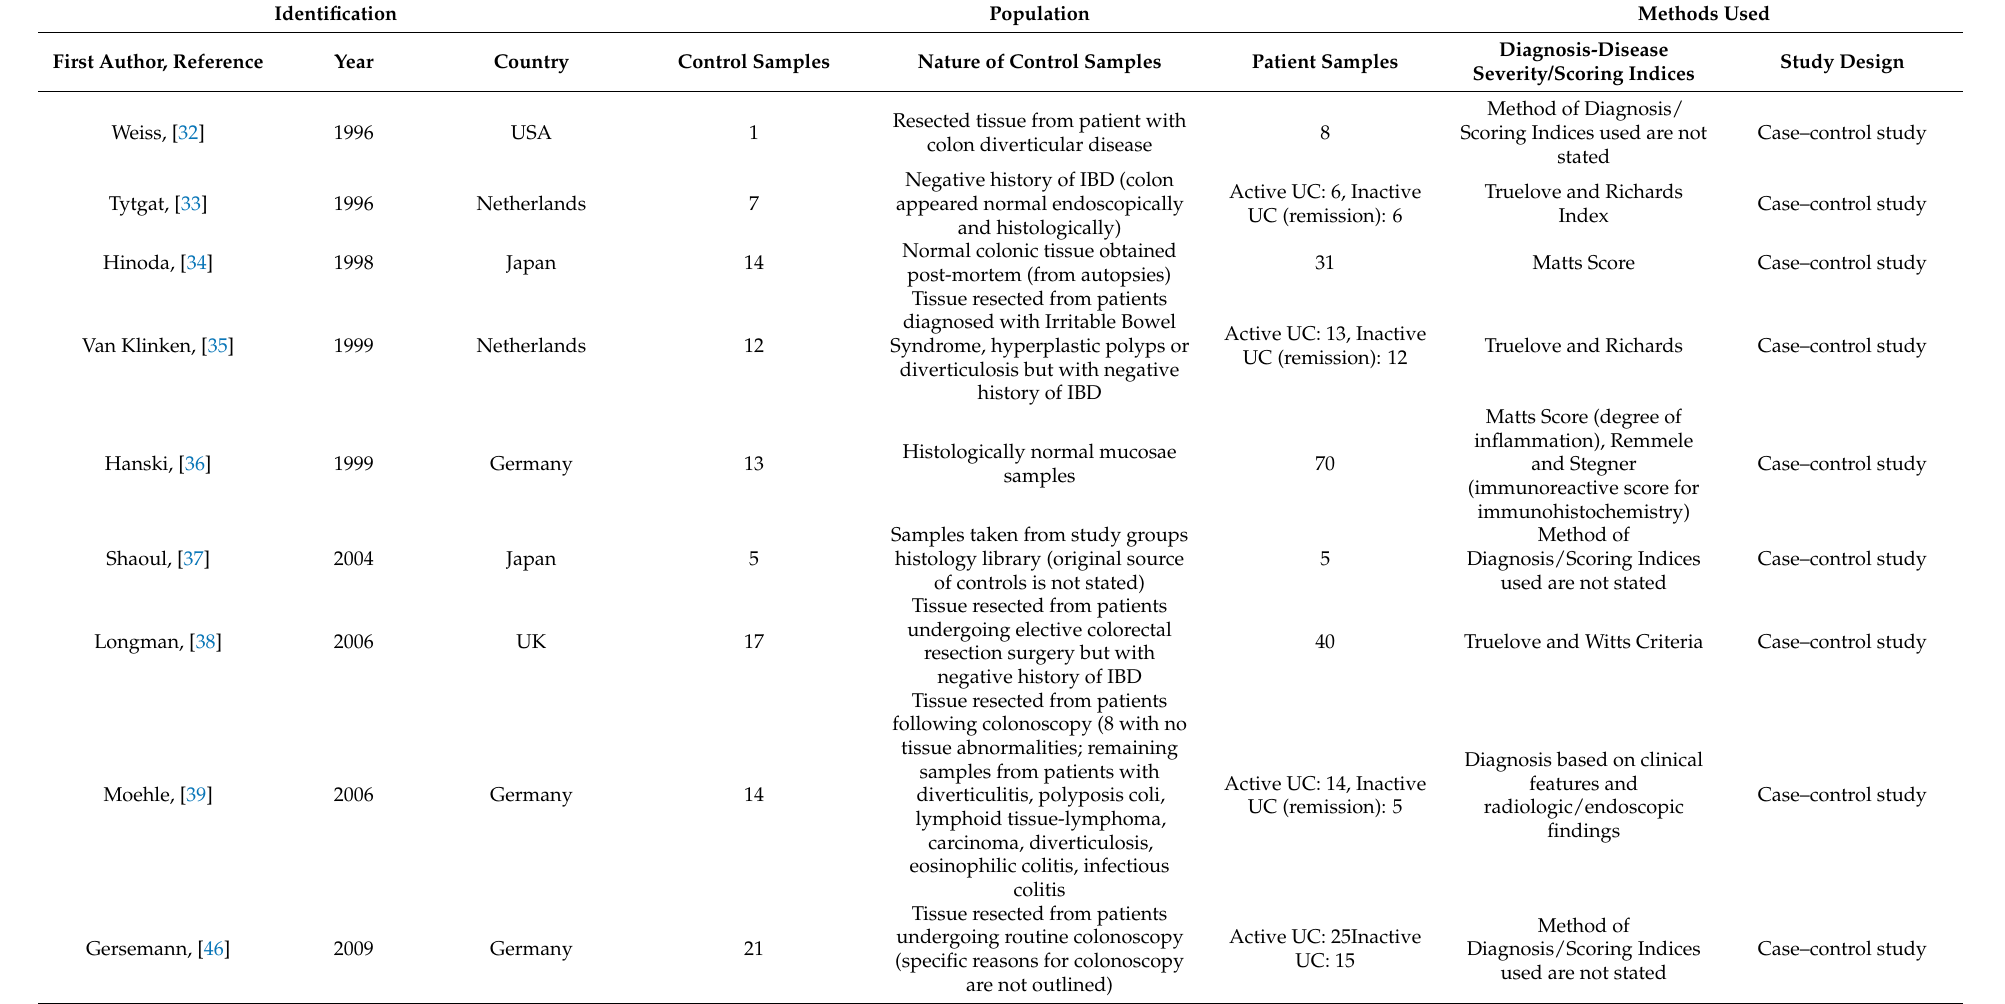
Table 1. Summary of the study design and sample characteristics for each of the included